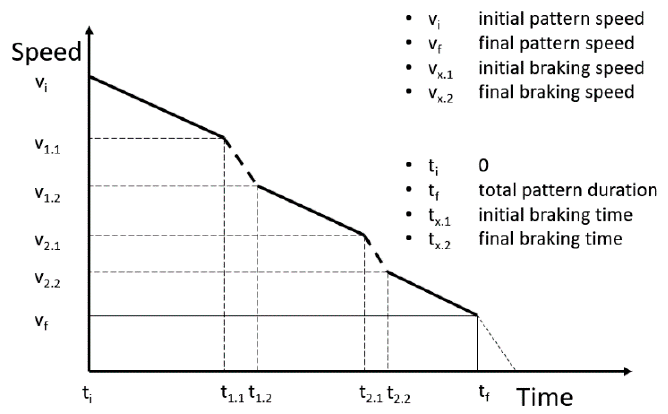
Figure 2. Long Pattern of Corrected Inertia.